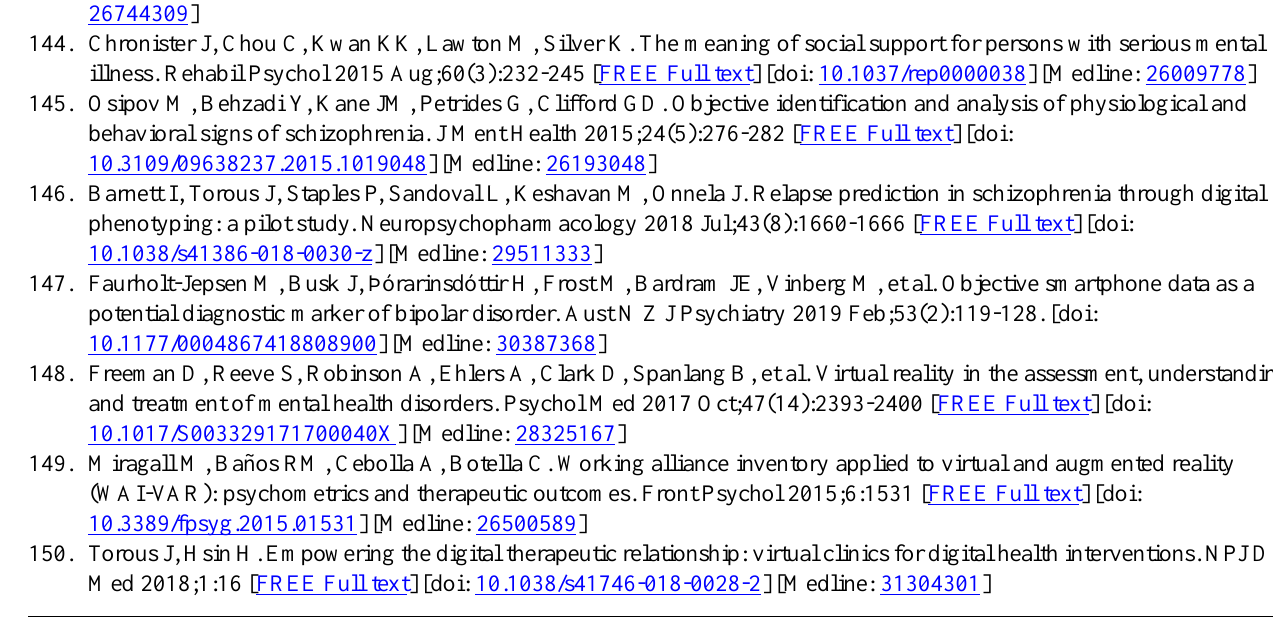
OCD: obsessive compulsive disorder PSD: persuasive systems